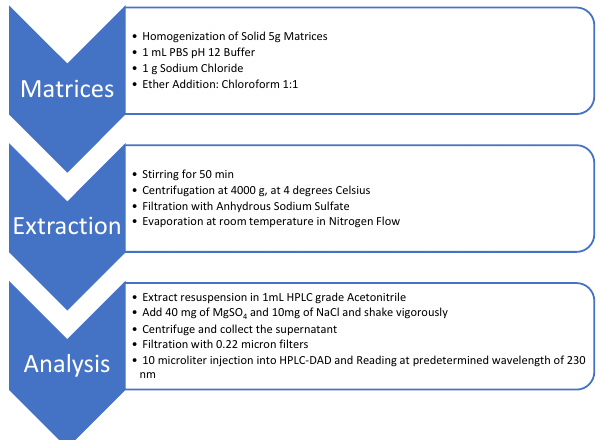
Figure 1. Flowchart for extraction and preparation of samples for analysis.